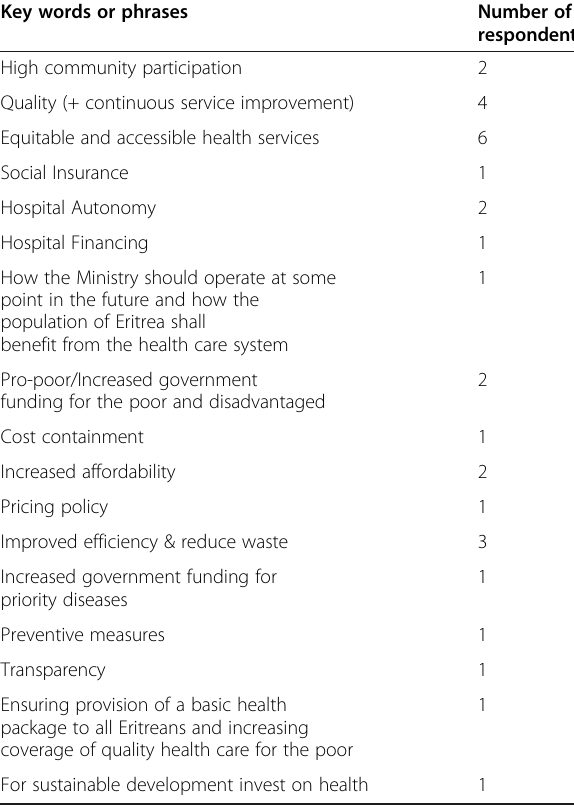
Table 3 Key words or phrases for inclusion in the vision of the national health financing policy